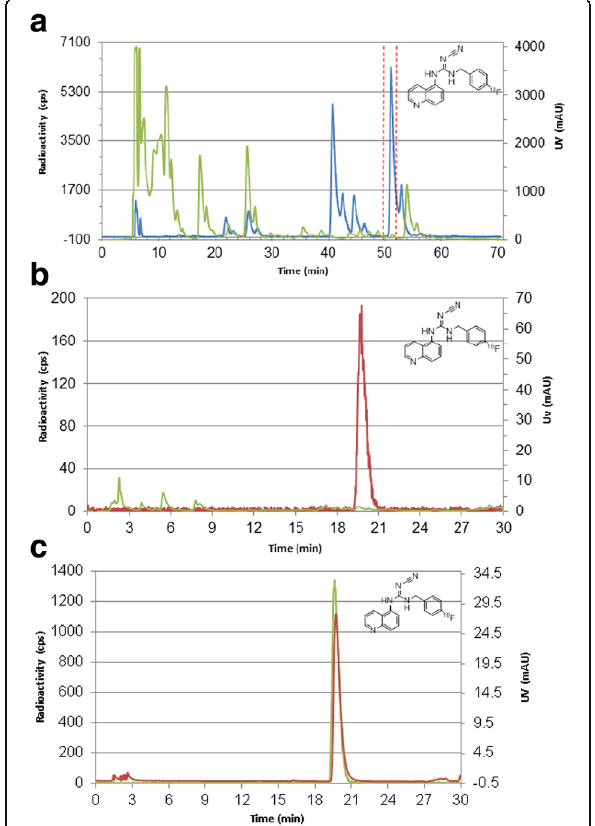
Fig. 6 a Semi-preparative purification of the product [ 18 F]EFB with HPLC high CP) with HPLC method B. c Identification of [ 18 F]EFB by co-elution with the reference standard with HPLC method B. Green chromatograms , UV; blue/red chromatograms , radioactivity. Only the region marked by the dashed red lines around 51 min was subject to collection